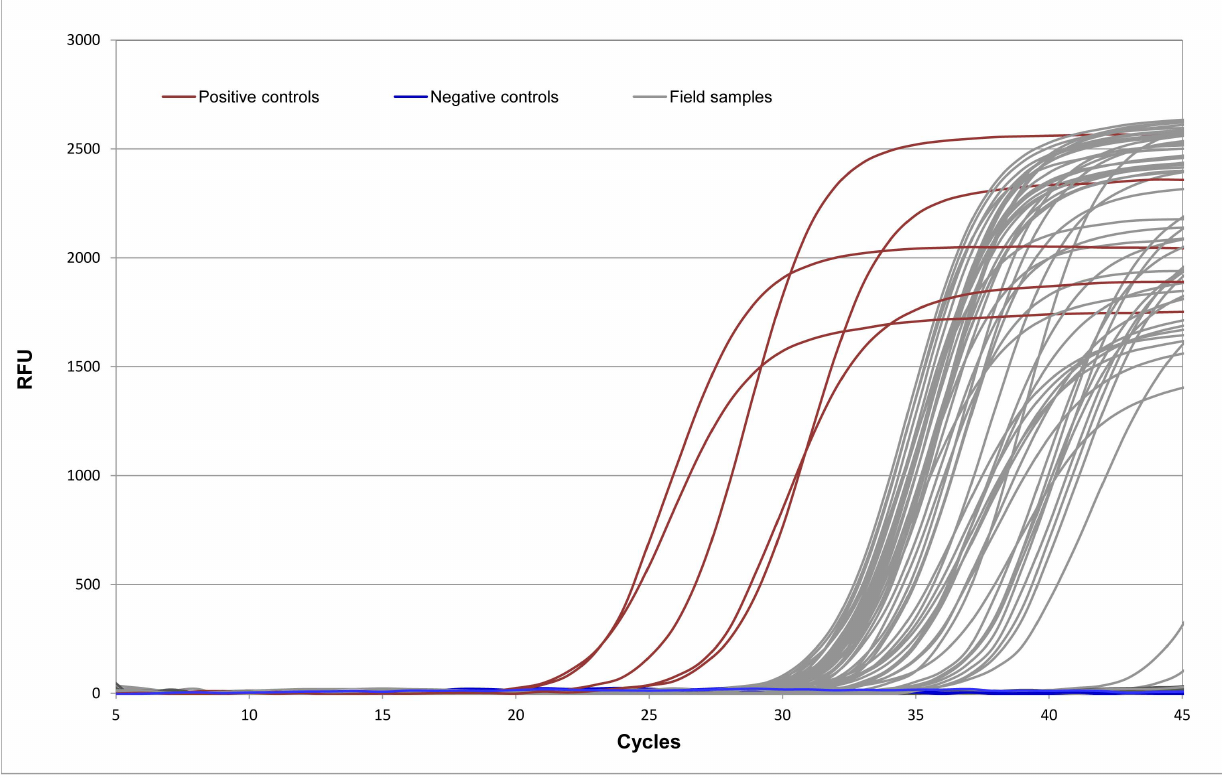
Figure 2. Parvovirus DNA amplification curves obtained during real-time PCR assays with tissue samples from wild carnivores. The relative fluorescence units (RFU) are plotted against cycle number. Ct variation was observed among positive samples from all surveyed species, with the exception of genet tissues, which yielded homogeneous values below 35. The average Ct was 34.73 cycles (standard deviation of 3.36). Values above 40 were considered negative. The Ct values of the positive controls used in each assay, a commercial vaccine containing the old CPV-2 strain, are also represented. Negative controls had no measurable fluorescence indicated by flat lines in the plot.